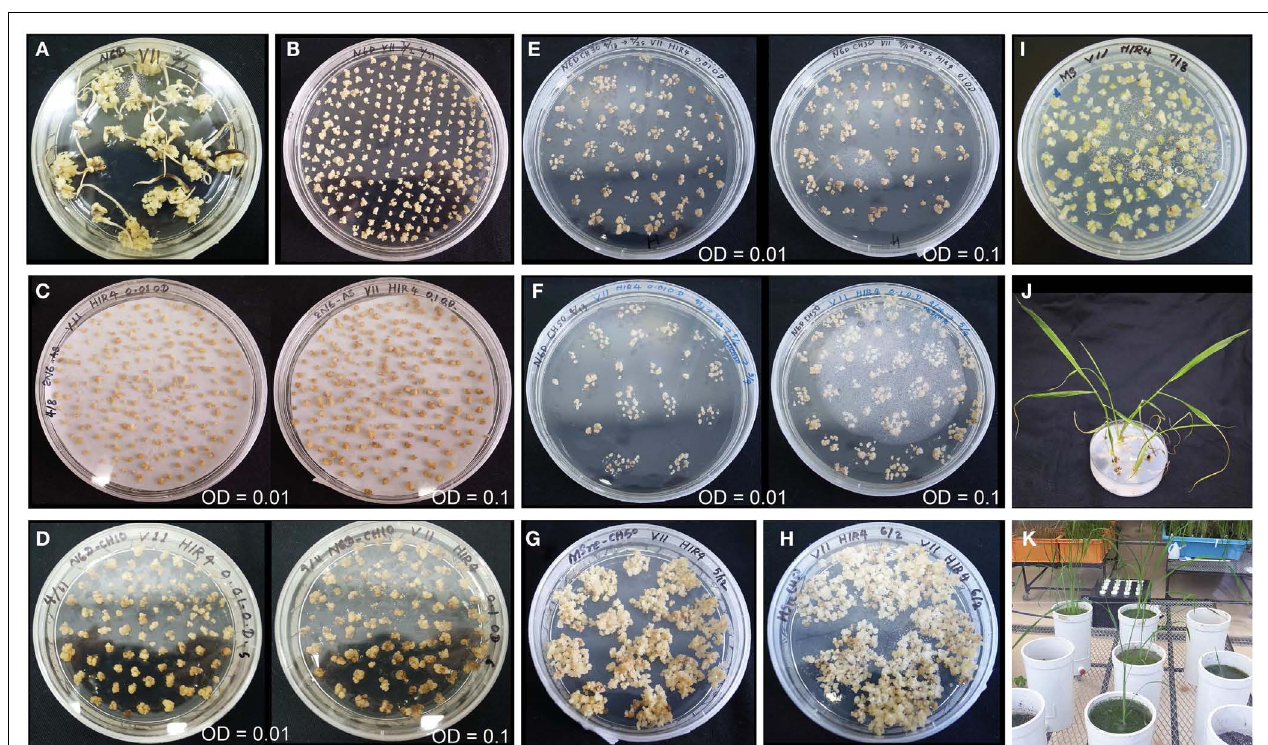
(I) Green spots appearance of calli and shoots emergence on MS medium (at 4 DAT). (J) Regenerated plants on MS medium. (K) Greenhouse-grownT 0 plants. Left panels of (C–F) show transformation with Agrobacterium at a concentration of OD = 0.01; right panels of (C–F) shows transformation at a concentration of OD = 0.1.The numerals shown with DAG or DAT mean DAG or DAT when photograph was taken on each